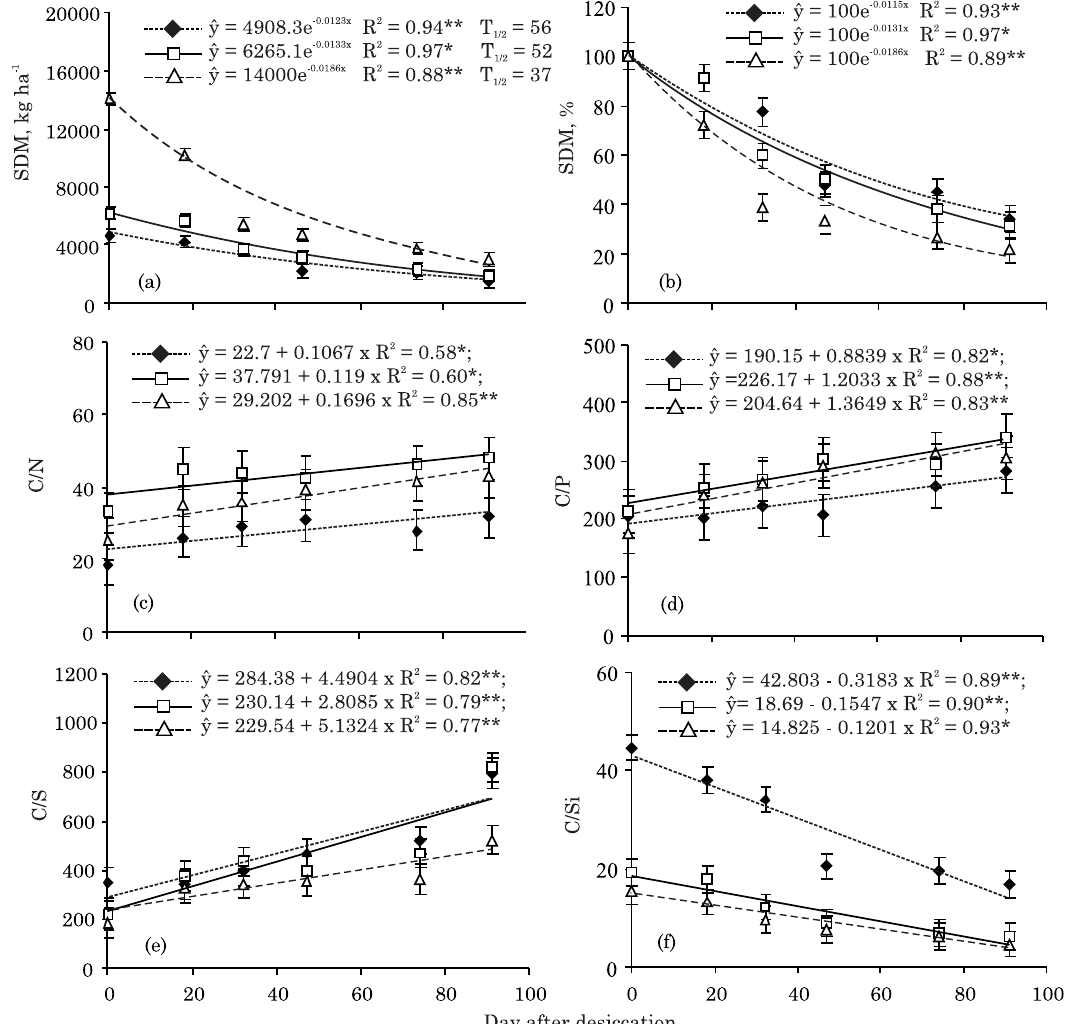
Figure 2. Shoot dry matter - SDM (a), percentage of plant dry shoot dry matter (b), C/N (c), C/P (d), C/S (e) and C/Si (f) ratios of pigeonpea ( ), pigeonpea+pearl millet ( ) and pearl millet ( ) shoot dry matter according to time after desiccation. ** and * significant at 1 and 5 % by the F test. T 1/2 refers to the half-life time in DAD. Vertical bars indicate the value of LSD at 5 % by the Tukey